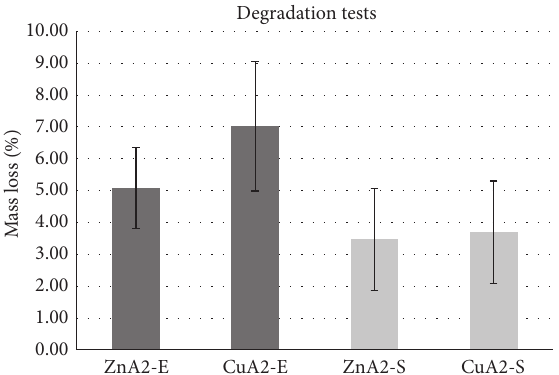
Figure 5: Results of degradation tests. Zn-S: ZnA2 conventional test, Cu-S: CuA2 conventional test, Zn-E: ZnA2 extreme test, and Cu-E: CuA2 extreme